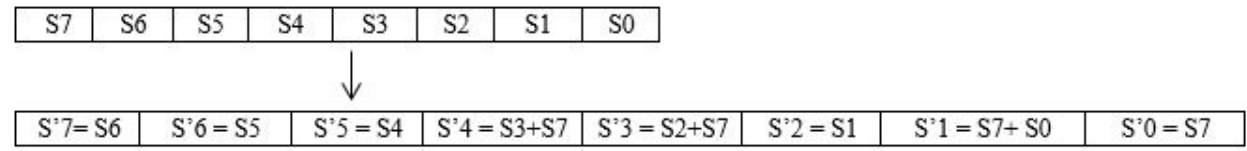
Figure 7. Multiplication process of 02 in GF.